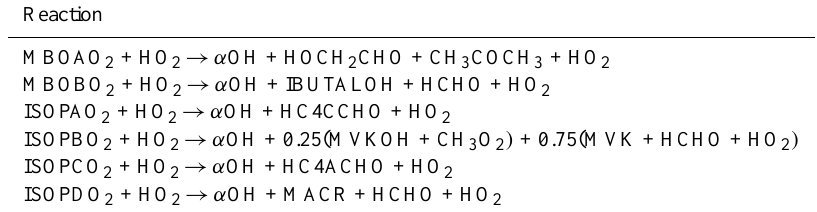
Table 3. Enhanced OH-recycling reactions. All reactions have a rate constant of 4.5 × 10 − 11 cm 3 molec − 1 s − 1 . α is set to 2.6. Reaction